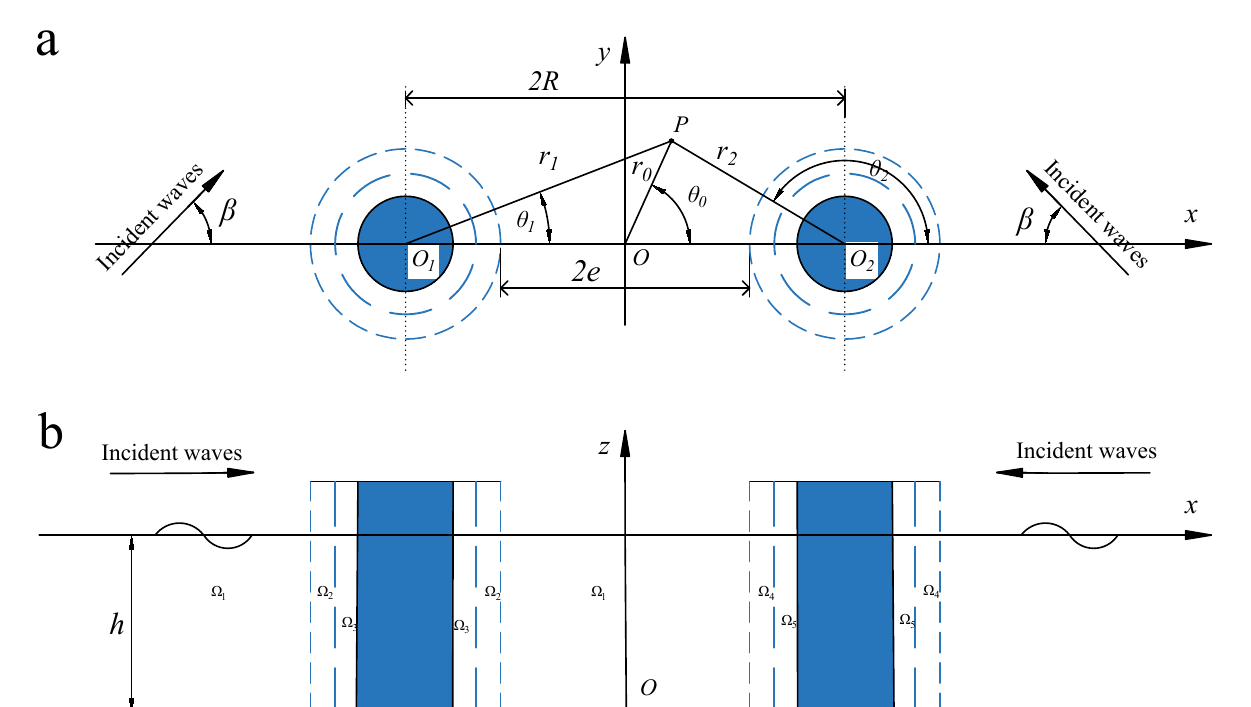
Figure 2. Imaginary system: ( a ) plane view; ( b ) side view. In the derivative process, the fluid is assumed to be incompressible and inviscid, and the motion of the fluid is considered irrotational. Then, the velocity potential can be written as Φ ( x , y , z , t ) = Re [ φ ( x , y , z ) e − iwt ] , in which φ is a time-independent velocity potential that satisfies the Laplace equation in every flow regions, i = governing equation for fluid motion is